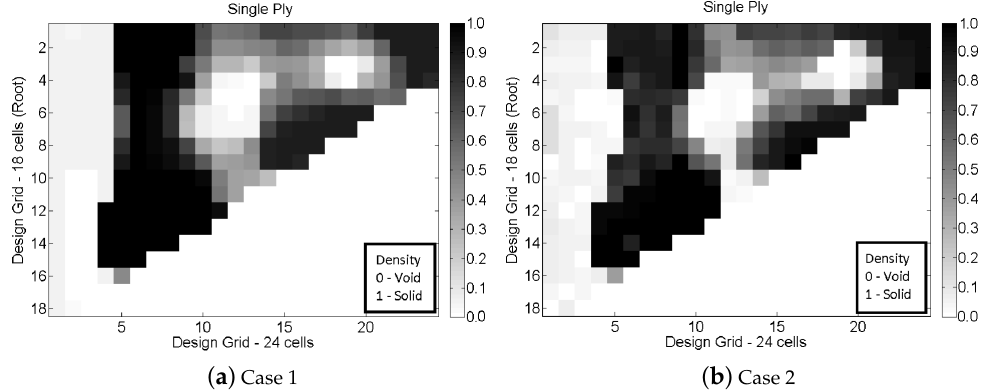
Figure 8. Topology optimization solutions of Cases 1 and 2.